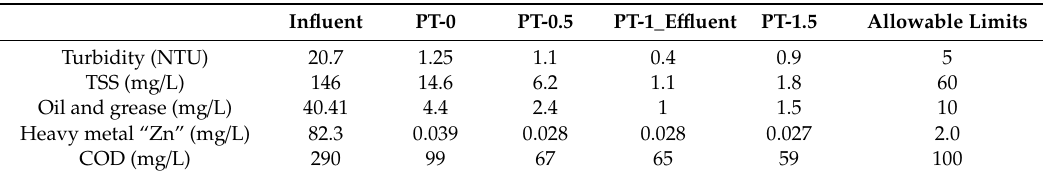
Table 6. Specifications of influent, e ffl uent water of PVC-TiO2NPs membranes and the allowable limits of Iraq for river discharged